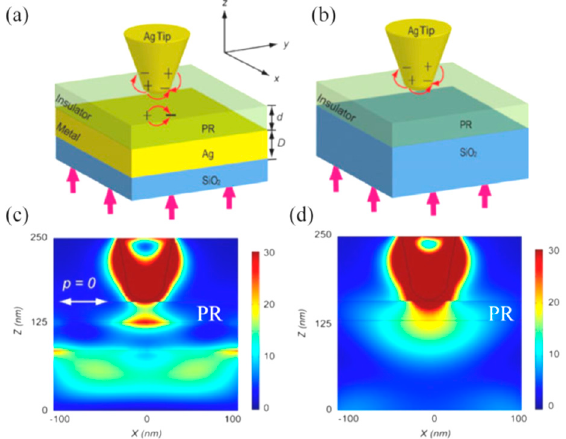
Figure 19. Schematic of nanolithography with ( a ) tip–insulator–metal and ( b ) tip–insulator structures; Simulated electric field intensity distribution of ( c ) tip–insulator–metal and ( d ) tip–insulator structures. Reproduced from [85], Copyright © 2013, Springer.